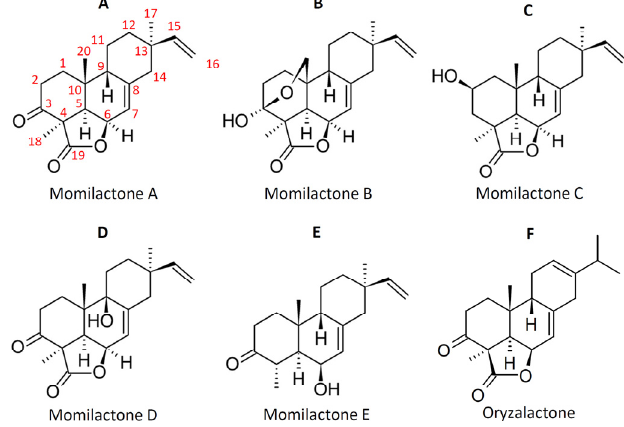
Figure 1. Momilactones so far isolated from rice ( A – E ) and oryzalactone ( F ). The dual role of phytoalexins and allelochemicals has been demonstrated for momilactone A and B. Momilactones share a pimarane skeleton, while oryzalactone exhibits an abietane skeleton.